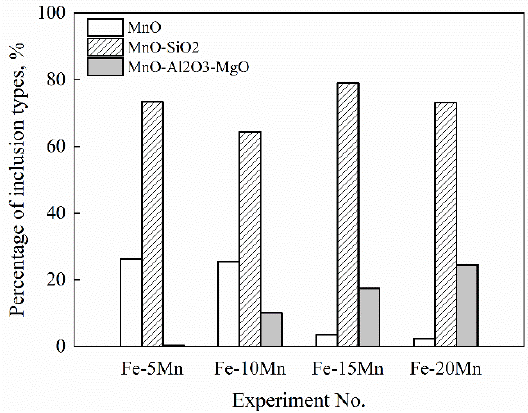
Figure 5. Percentage of inclusion types.